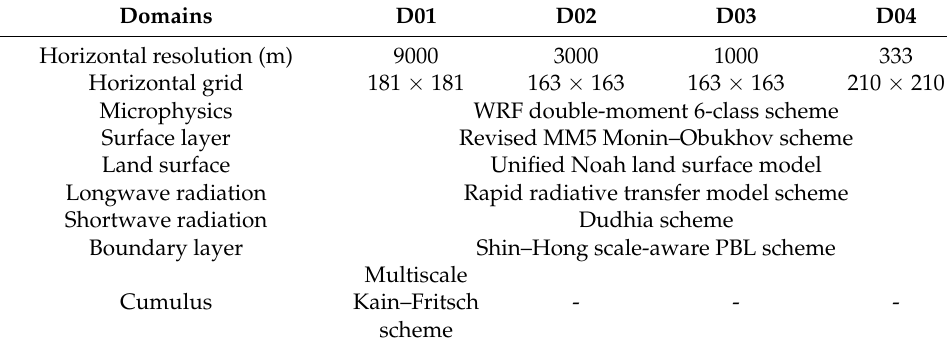
Table 1. Configuration of the WRF